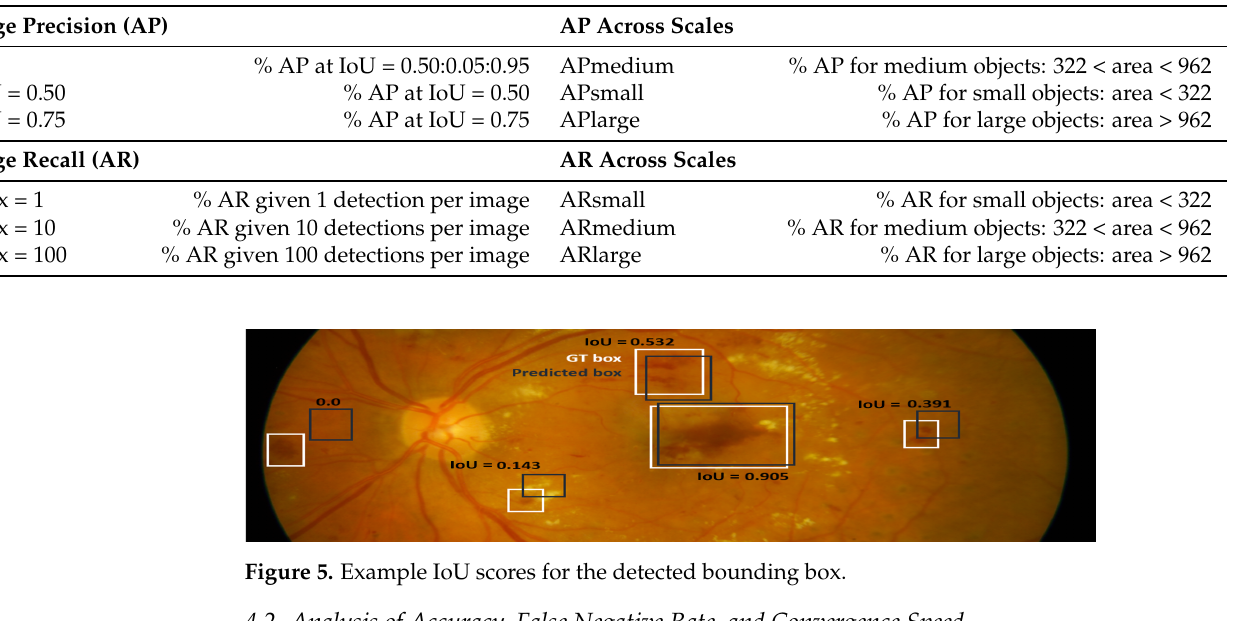
Table 2. Evaluation metrics from COCO [35] used to assess the performance of object detection models on the COCO dataset. These evaluation metrics include Average Precision (AP) and Average Recall (AR) for bounding box detection, as well as AP and AR for different object sizes and IoU thresholds.